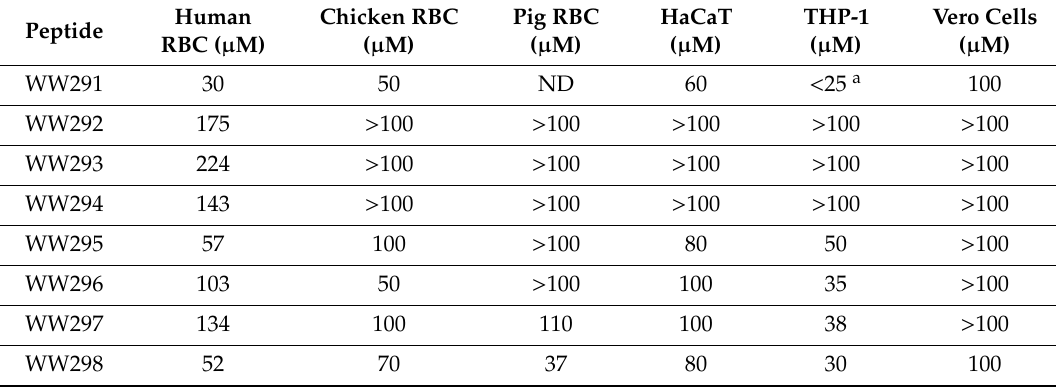
Figure 2. Assessment of the cytotoxicity of sequence-permutated peptides WW291-298 on human monocytes (THP-1). Panels ( A – H ) represent cell viability after each peptide treatment at concentrations in the range of 12.5 to 100 µM. Cell viability was quantitated using the standard MTS assay (see Methods). Table 4. Toxicity of the WW peptides to red blood cells or mammalian cells a.